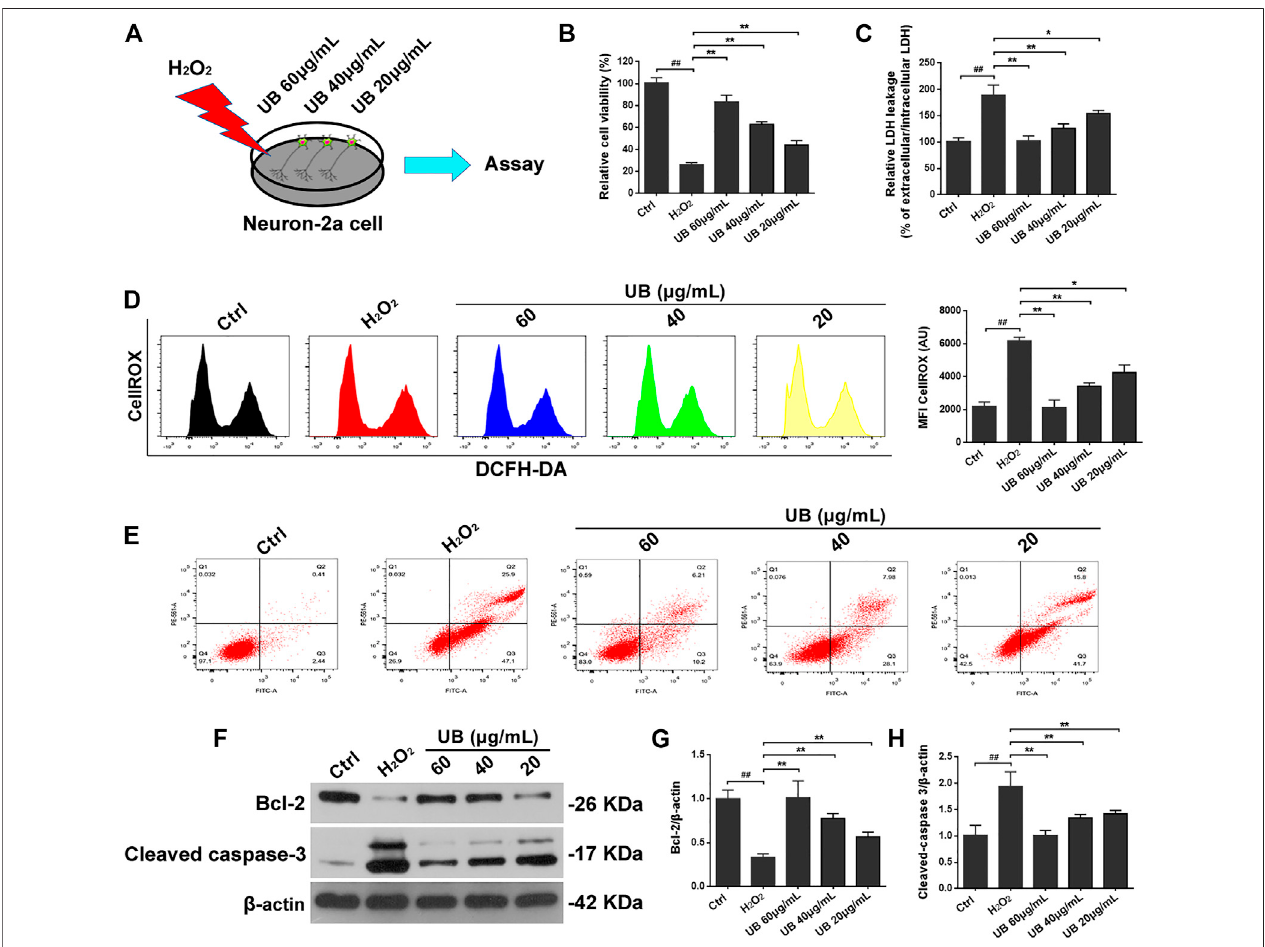
FIGURE 1 | (A) The schematic diagram of the cell experimental design for H 2 O 2 -induced In fl ammatory injury model and UB treatment. The protective effect of UB on neuron-2a cells against H 2 O 2 -induced viability (B) and cytotoxicity (C) . (D) UB inhibited ROS accumulation in neuron-2a cells, as determined by fl ow cytometry. (E) The anti-apoptotic effect of UB against H 2 O 2 -induced neurotoxicity inneuron-2a. (F) The expression of cleaved caspase-3 and Bcl-2 was detected by western blotting. Quanti fi cation analysis of cleaved caspase-3 (G) and Bcl-2 (H) . Data were normalized to β -actin protein expression. All results are described as means ± SD ( n (cid:1) 3 per group). # p < 0.05 and ## p < 0.01 vs the control group; * p < 0.05 and ** p < 0.01 vs the H 2 O 2 -treated